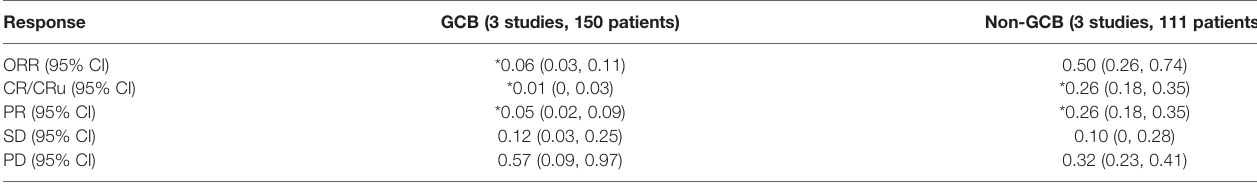
TABLE 5 | Pooled response rates in patients with GCB and non-GCB phenotypes who received maintenance treatment consisting of lenalidomide monotherapy.